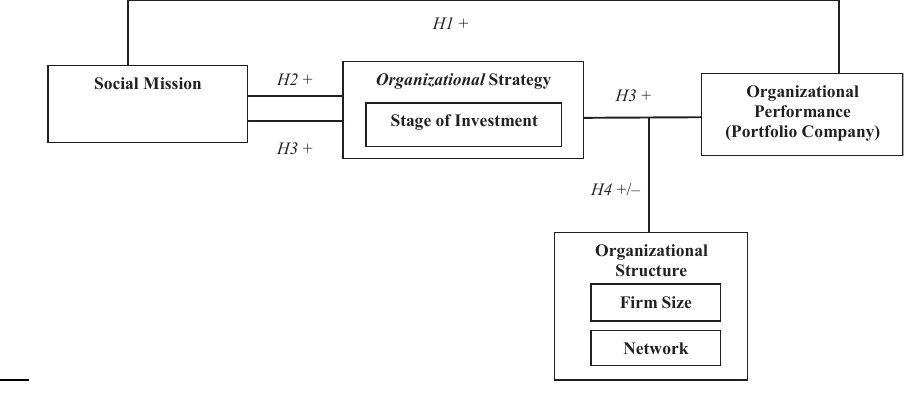
Figure 1. Theoretical